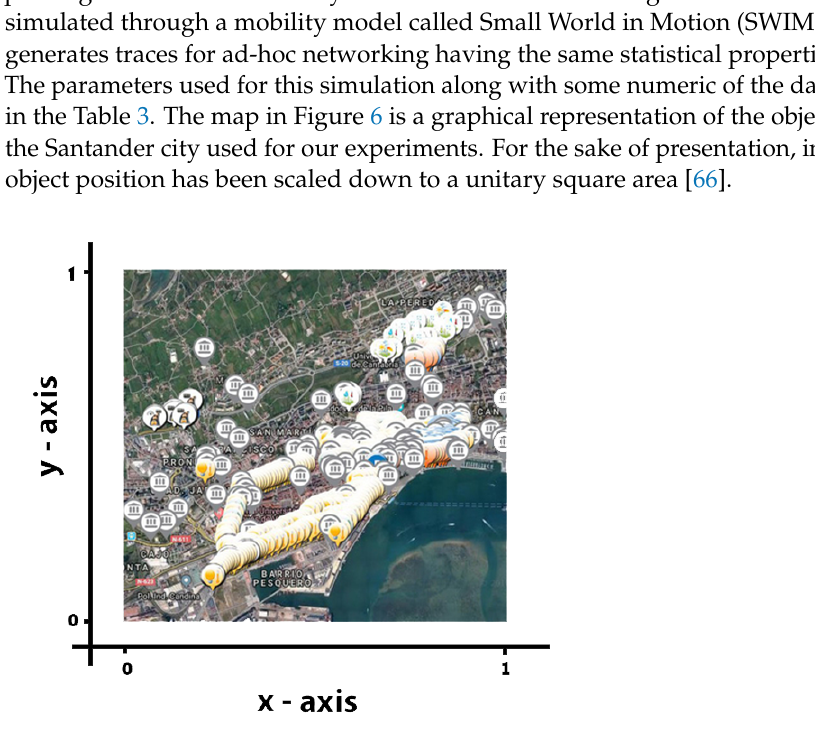
Figure 6. The maps of smart things of Santander used in our